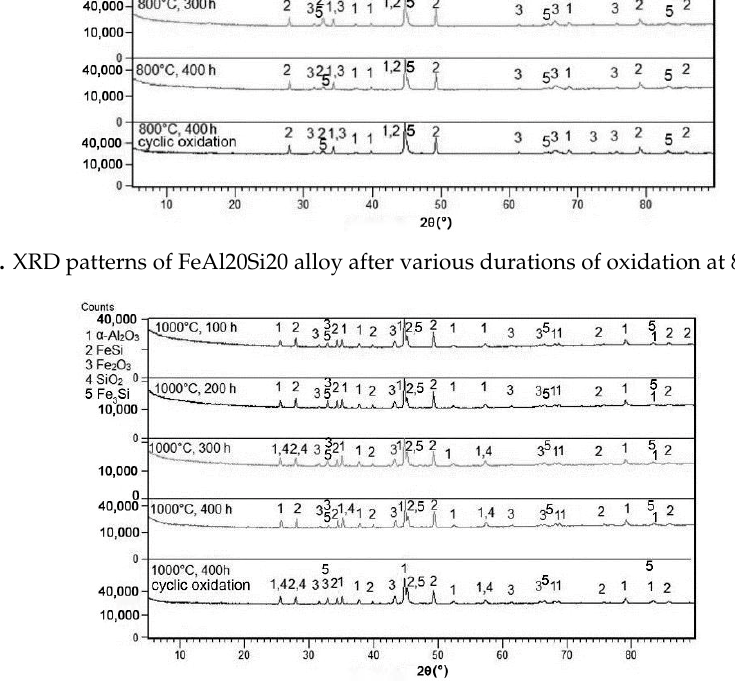
Figure 4. XRD patterns of FeAl20Si20 alloy after various durations of oxidation at 1000 °C in